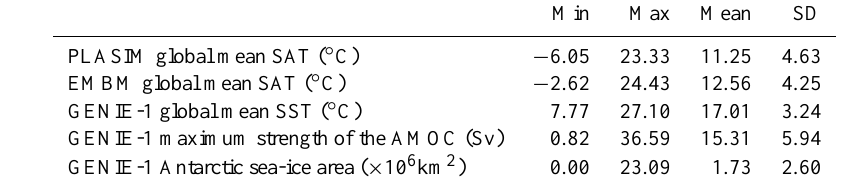
Table 2. A summary of the simulated climate states from the 600-member ensembles of GENIE-1 with EMBM and PLASIM.